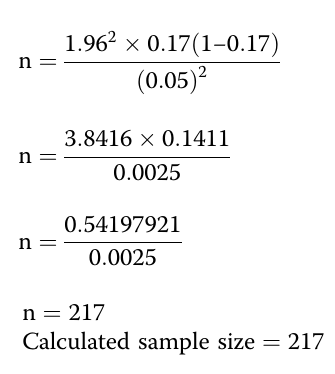
Sample size The sample size determination was based on the 17% prevalence of injection palsy yearly as reported by Fatunde and Famulusi in Nigeria [21] and